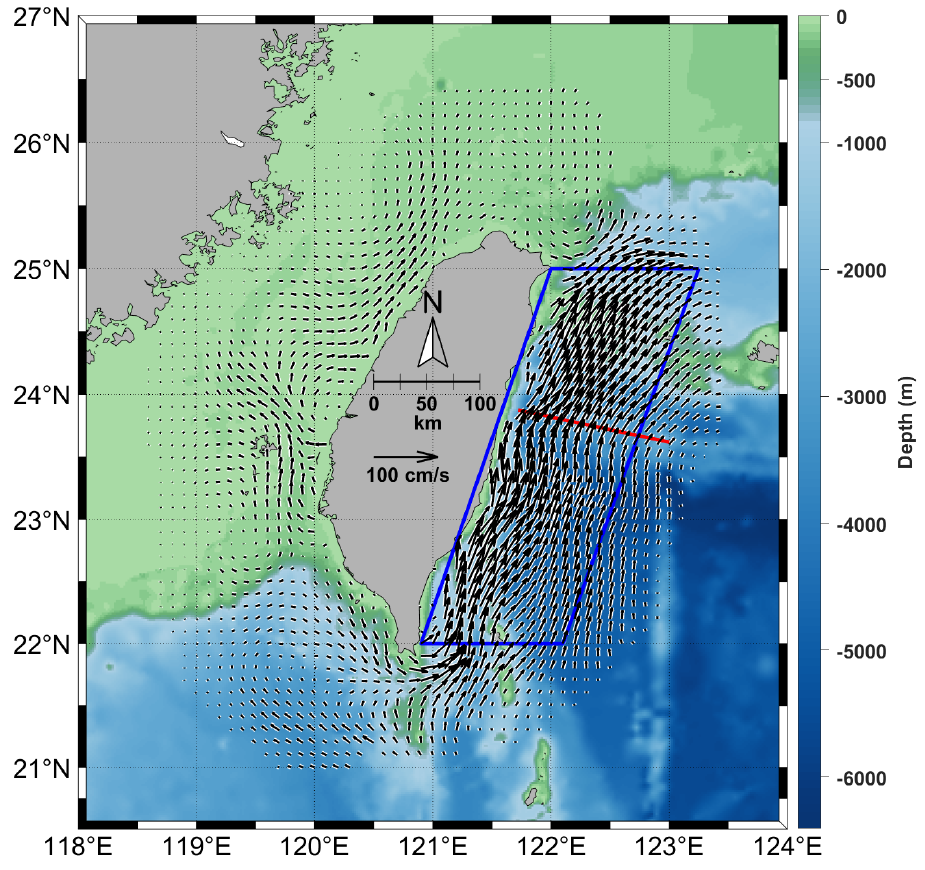
Figure 4. Mean current field of reconstructed data and the KTV1 line (red line). The blue parallelo- gram stands for the area of core current.